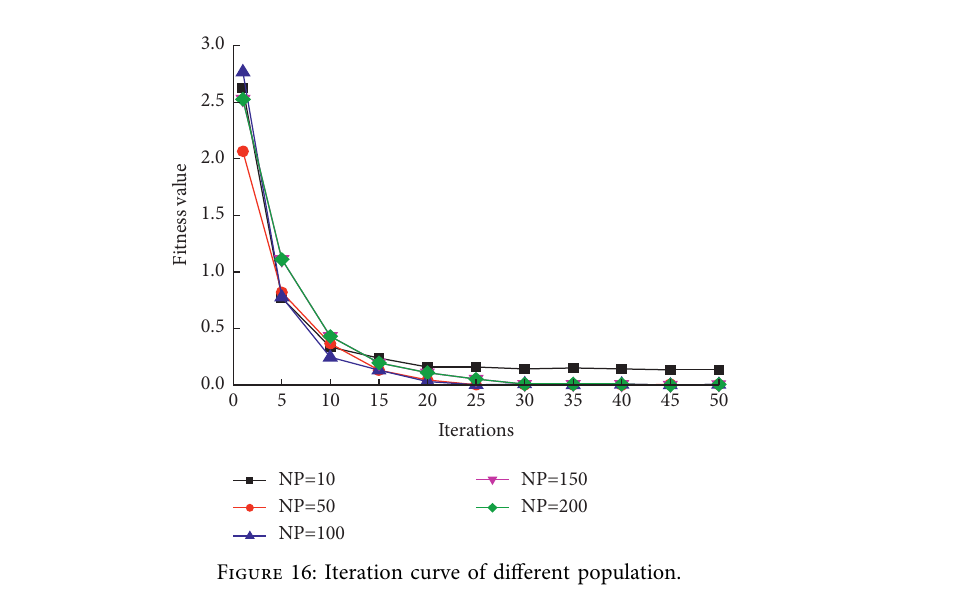
Figure 15: Iteration curve with change of CR and F : (a) F � 0.6. (b) CR � 0.9.